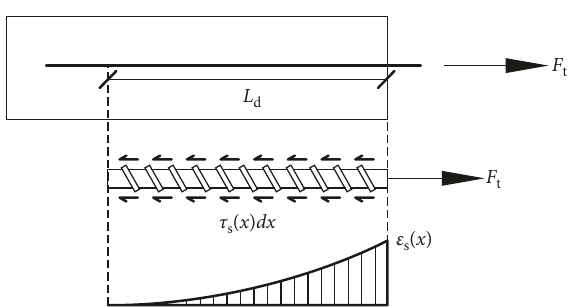
Figure 13: Equilibrium of the anchorage reinforcement with de- velopment length L d . Table 9: Empirical expressions of strain penetration length L Reference Strain penetration length, L